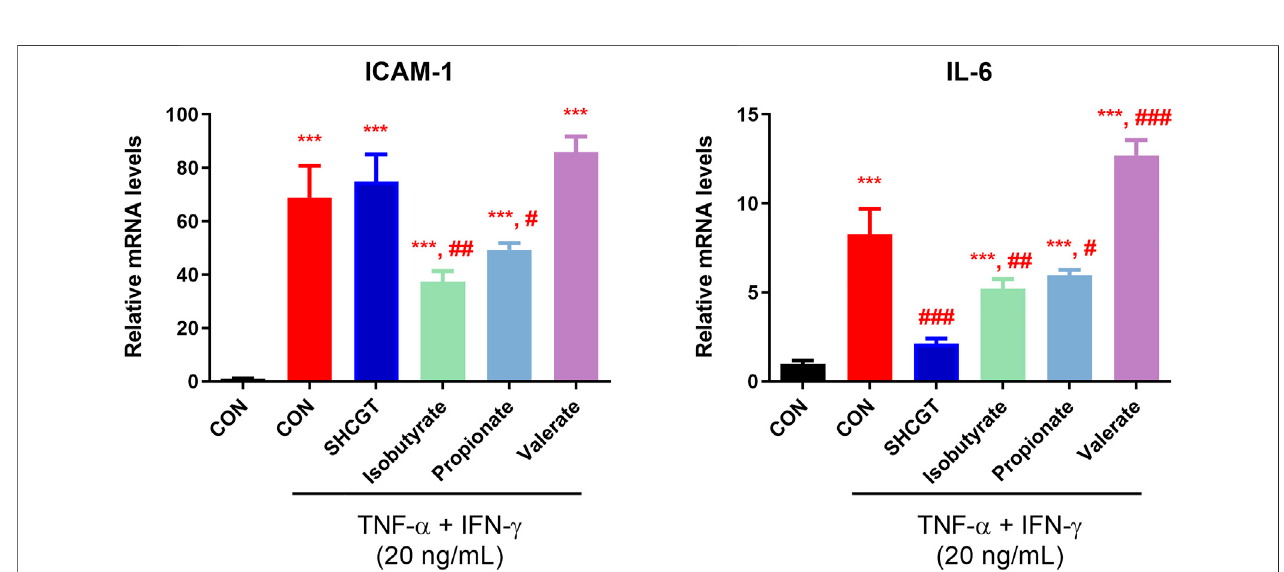
FIGURE 8 | Gut microbiome-related metabolites (short-chain fatty acids) had a bene fi cial effect on TNF- α /IFN- γ -treated HaCaT cells. Isobutyrate and propionate directlyreducedthe expression levels ofICAM-1and IL-6in TNF- α /IFN- γ -treated HaCaT cells.*** p < 0.001 vs. CON; # p < 0.05, ## p < 0.01, ### p < 0.001 vs. TNF- α /IFN- γ -treated CON (CON + TNF- α /IFN- γ ). AD, atopic dermatitis; CON, control HaCaT cells; DNCB, 2,4-dinitrochlorobenzene; ICAM-1, intercellular adhesion molecule-1; IFN- γ , interferon-gamma; IL-6, interleukin-6; SHCGT, Sihocheonggan-Tang ; TNF- α , tumor necrosis